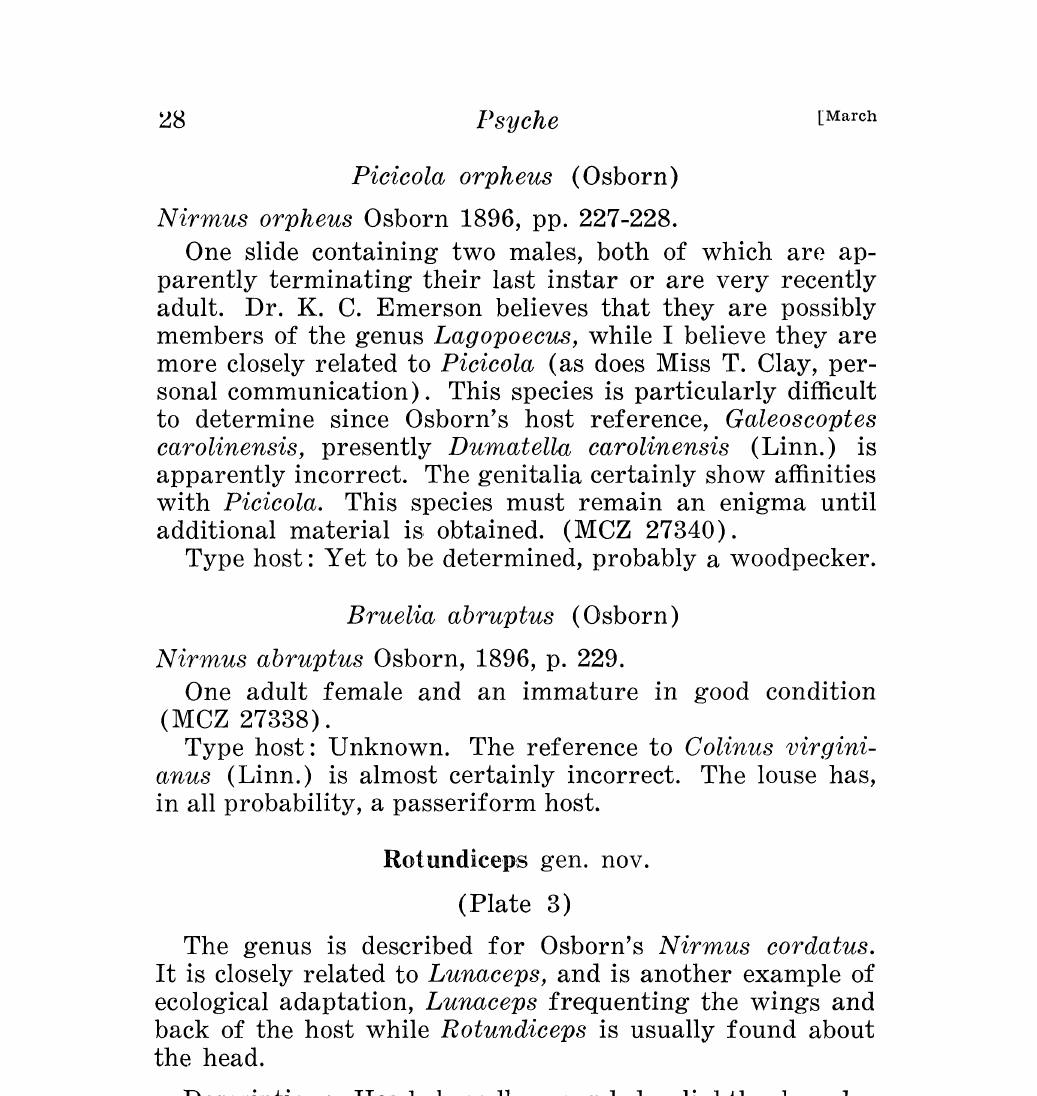
Fig. 1. Dorso-ventral view of male Rotundiceps cordatus Osborn. Fig. 2. Male